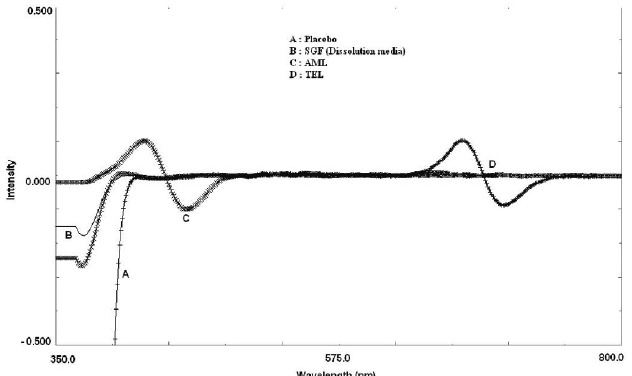
FIGURE 6 - Synchronous first order derivative spectrum of placebo (A), blank dissolution medium (B), AML (C) and TEL (D).